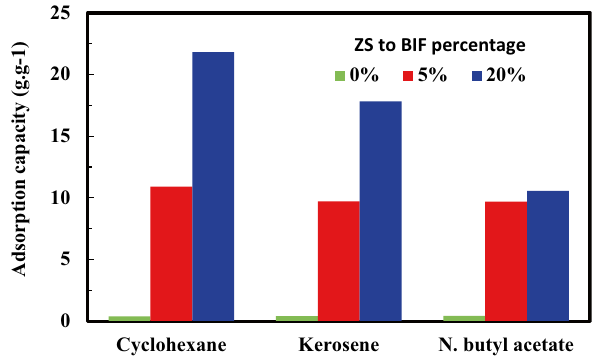
Figure 7. The adsorption capacity of oil on ZS@BIF treated with different percentages of ZS to BIF composite.